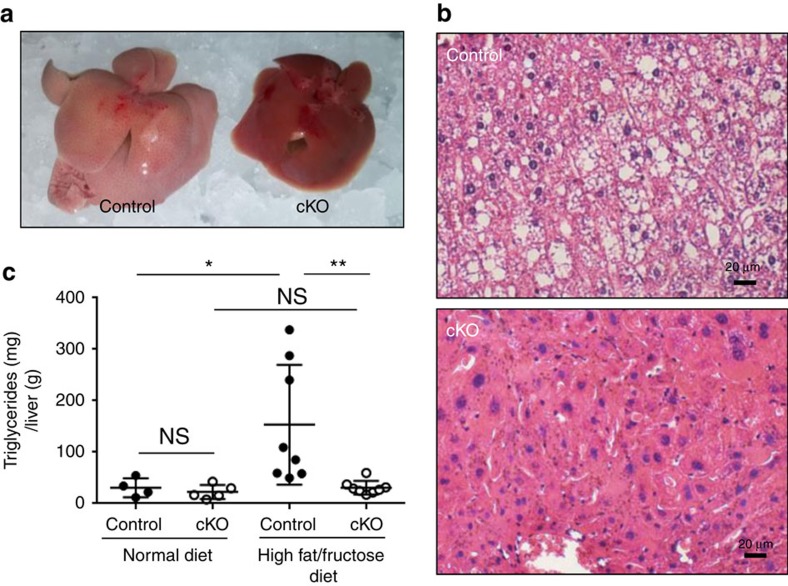
Ant2-deletion in the liver prevents fatty liver development under a high fat/fructose diet.Control and Ant2 cKO mice at the age of 6 weeks were subjected to a high fat (40%)/high fructose (20%) diet for 8 weeks. (a) Representative images of liver gross appearance (n=8). (b) Representative images of liver histology analysis with H&E staining (n=10). Scale bar; 20 μm. (c) Total triglyceride levels in the liver under a normal or high fat/fructose diet (n>5, *P<0.05, **P<0.01 by t-test, error bars=s.d.).